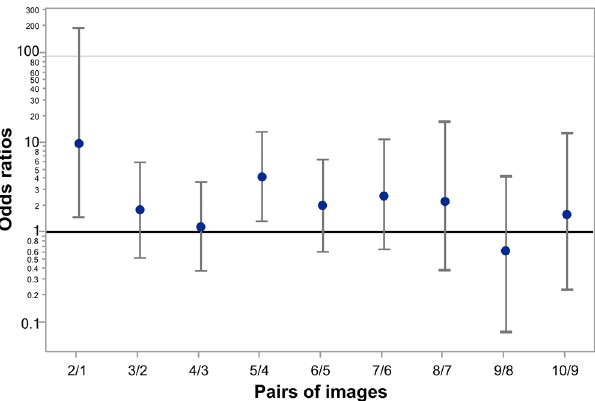
Figure 5. Odds ratios of face recognition between pairs of Face-n-Food images. Vertical bars represent 95% CI. The significant leaps in face recognition occur from the image 1 to 2 and image 4 to 5. The odds ratios for all other pairs do not differ from 1, indicating the lack of increase in face